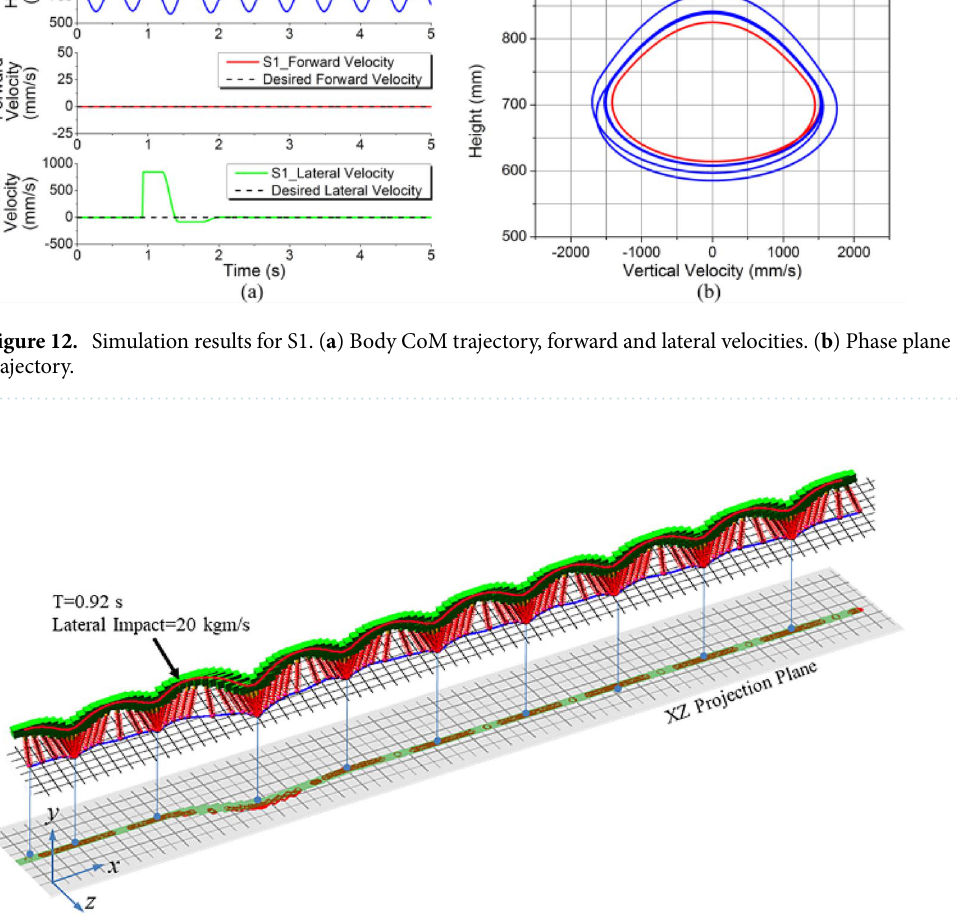
Figure 13. Motion sequence diagram for forward running SLIP system under compound